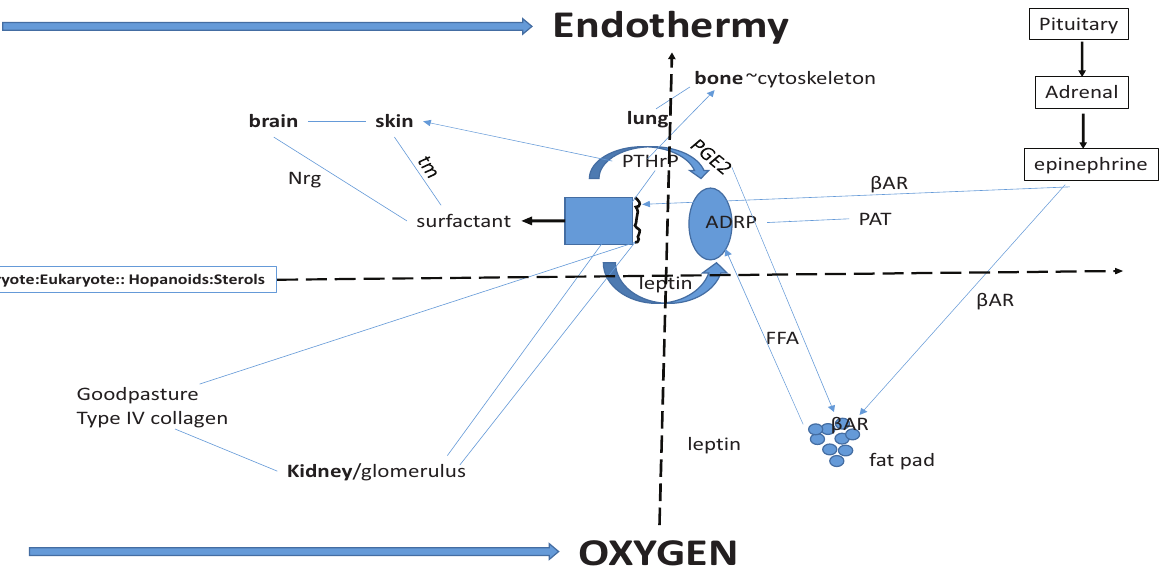
Figure 2. Origins of Vertebrate Physiologic Homologies. Sterols (far left) under the control of Hypoxia Inhibitory Factor-1 (Hif-1) link prokaryotes and eukaryotes together functionally; thus the major vertebrate physiologic homologies are linked through the induction of endothermy (top solid arrow) by atmospheric oxygen (bottom arrow). In the center of the Schematic is the molecular regulation of alveolar surfactant production. It is homologous with brain (neuregulin (NRG), and skin (tubular myelin (tm), both of which are under Parathyroid Hormone-related Protein (PTHrP) regulation. Lung and bone share functional homology through PTHrP stretch-regulated metabolism. Prostaglandin E2, leptin, Adipocyte Differentiation Related Protein (ADRP) and (cid:2)Adrenergic Receptor ((cid:2)AR) share homologies with fat